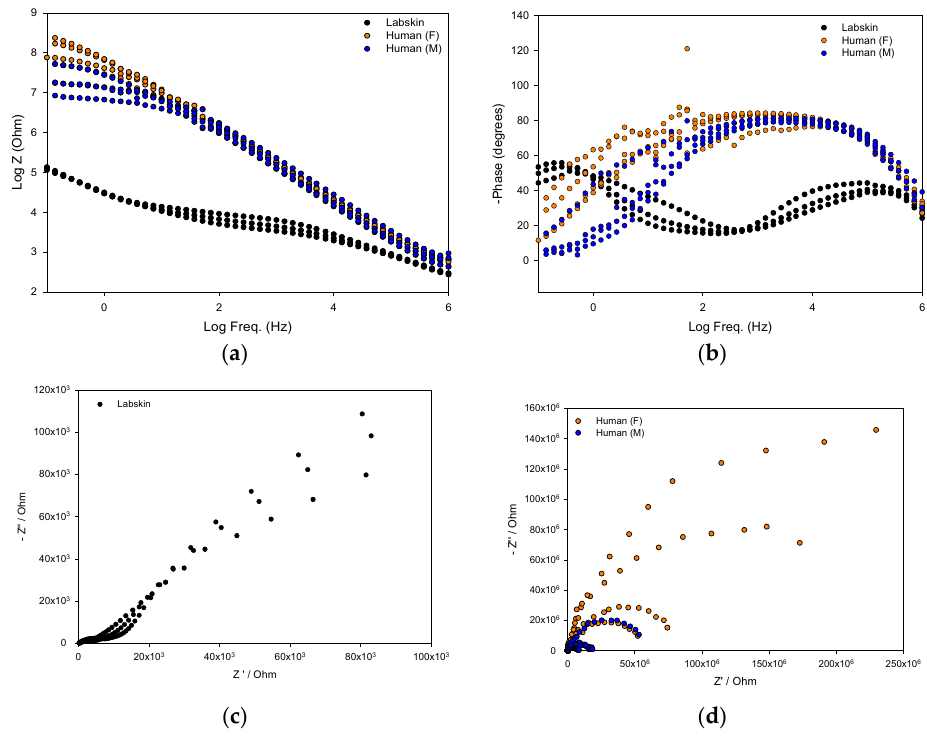
Figure 3. Overlaid impedance measurements represented as ( a ) Bode plot; ( b ) Phase plot; and Nyquist plots for Labskin ( c ) and human skin ( d ); Measurements were obtained impedimetrically from the tattoo sensor on 8 human participants (female—orange; male—blue) and on Labskin (black).